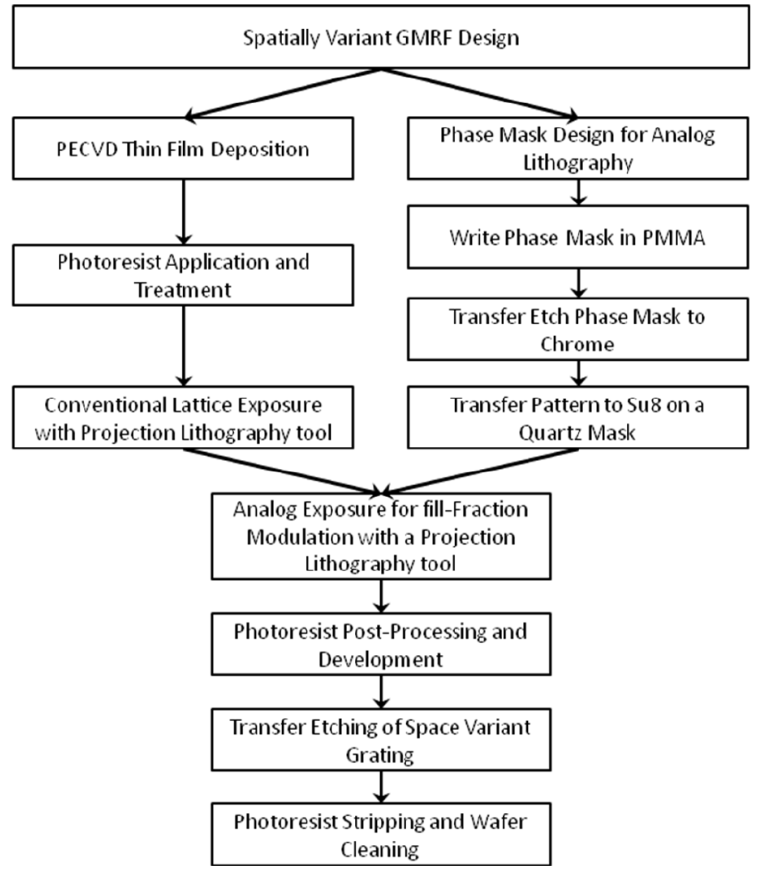
Figure 8. Process flow for the Space Variant GMRF